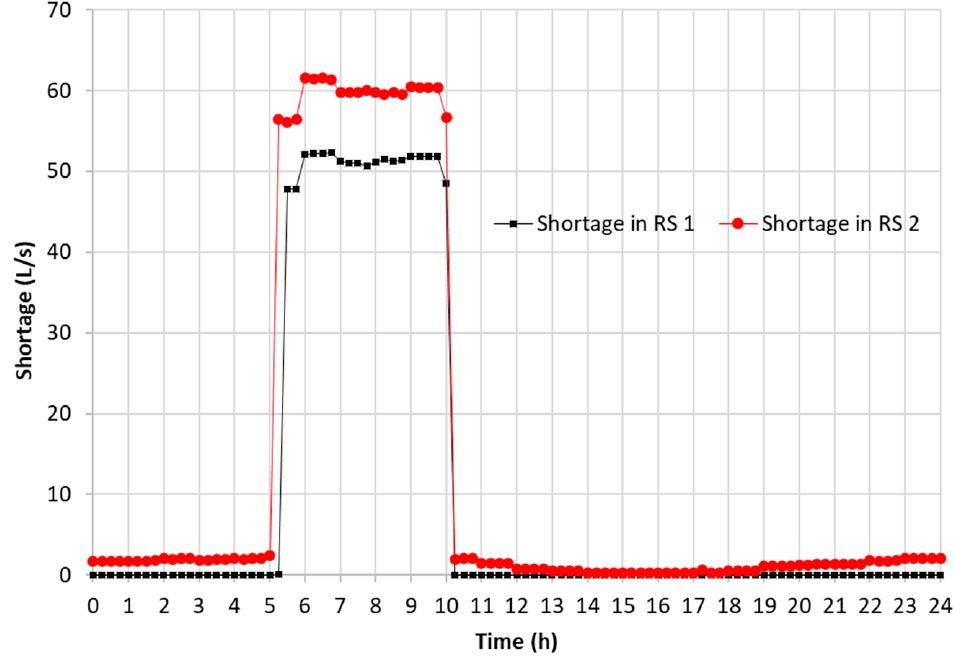
Figure 7. Comparison of unmet demand results for RS 1 (black line) and RS 2 (red line).